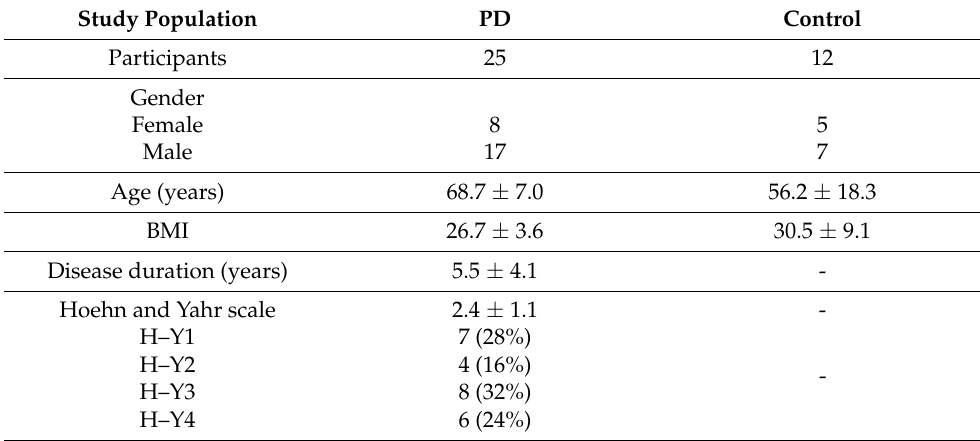
Table 1. Stratification of tested population (mean ±